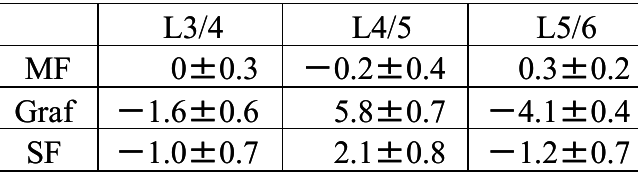
Table 1 Segmental Lordosis to Intact(Deg.). Application of the Graf system forces the segment in lordosis compared to the intact spine, and to compensate for the extended alignment, the adjacent segment flexed and its lordosis